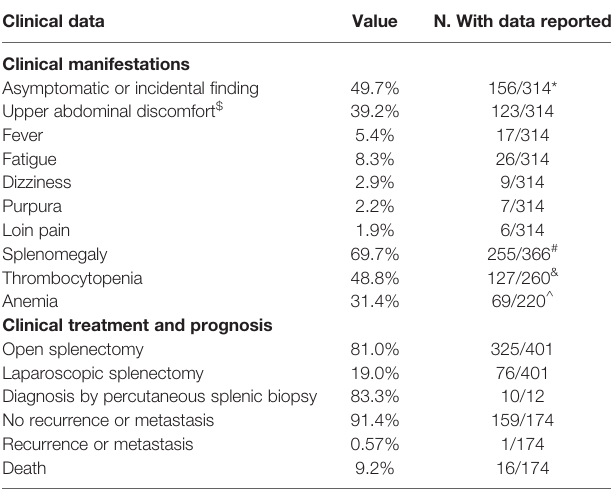
TABLE 2 | Quanti fi cation and analysis of the clinical manifestations and prognosis. Clinical data Value N. With data